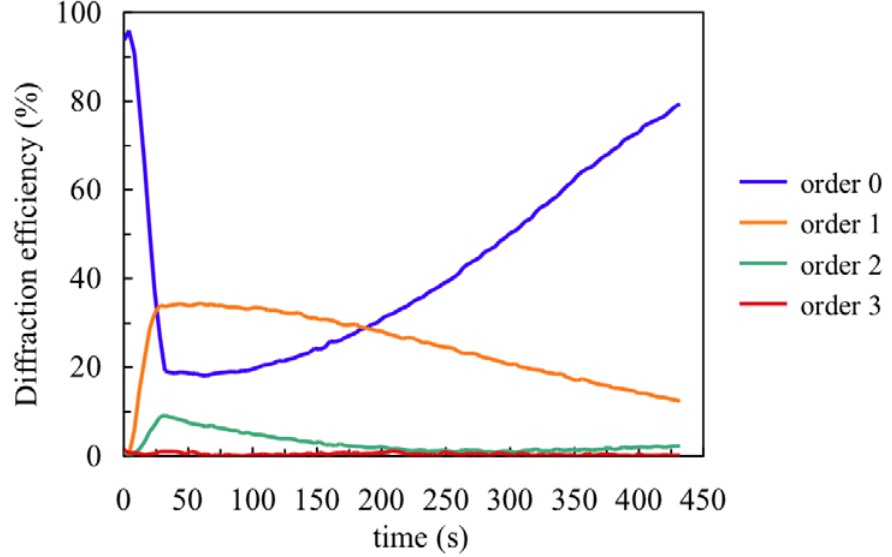
Figure 5. Fourth first reflected orders for composition